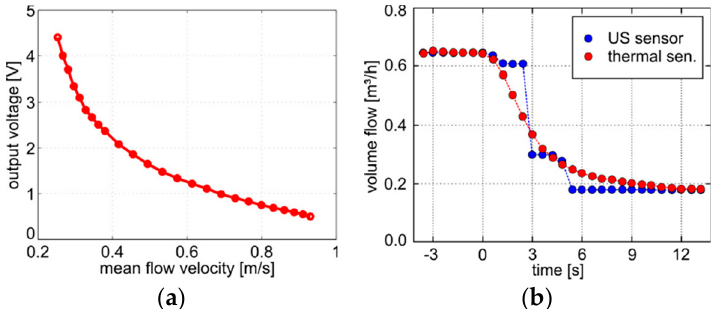
Figure 4. ( a ) Measured output characteristic of the non ‐ invasive thermal flow sensor; ( b ) Comparison of the sensor response after a sudden change of the volume flow for a typical clamp ‐ on US sensor and the non ‐ invasive thermal flow